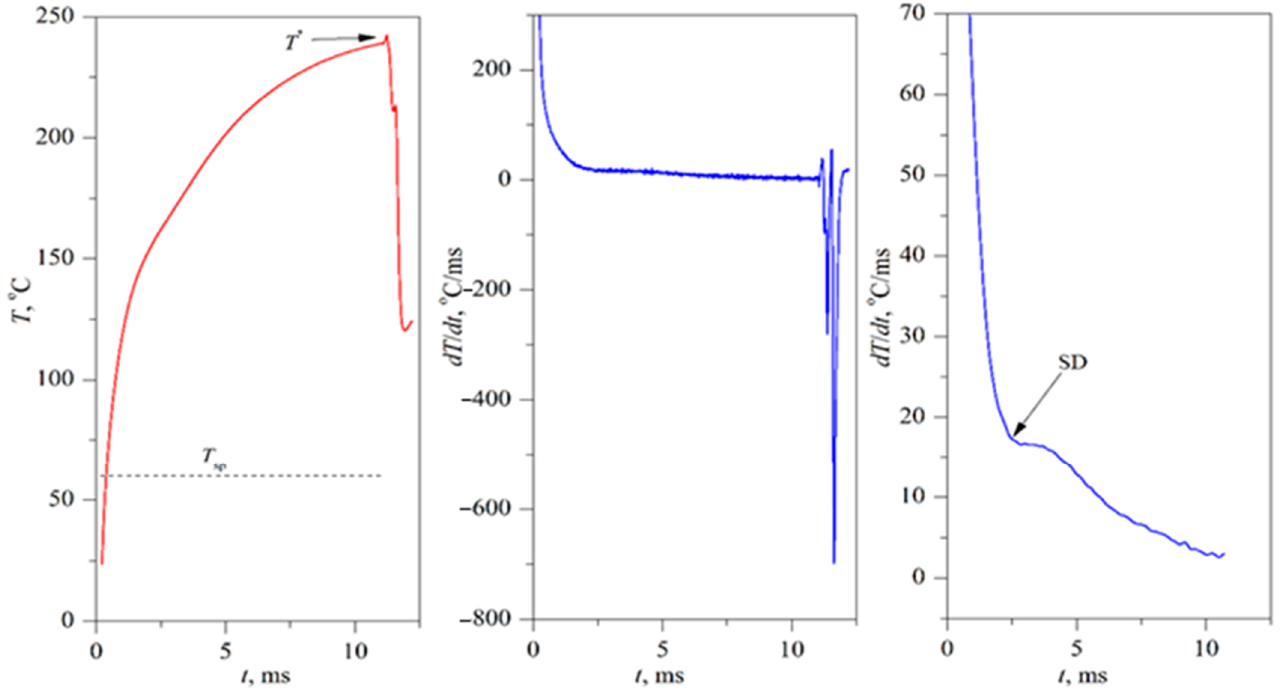
Figure 4. Probe temperature evolution for 30 wt.% mixture of PPG-425 in water that has LCST under the constant heating power mode P = 8.5 W and its time derivative; T sp —diffusion spinodal temperature; T *—spontaneous boiling-up temperature at p = 0.1 MPa; SD—onset of the decomposition of the mixture by the liquid–liquid mechanism.